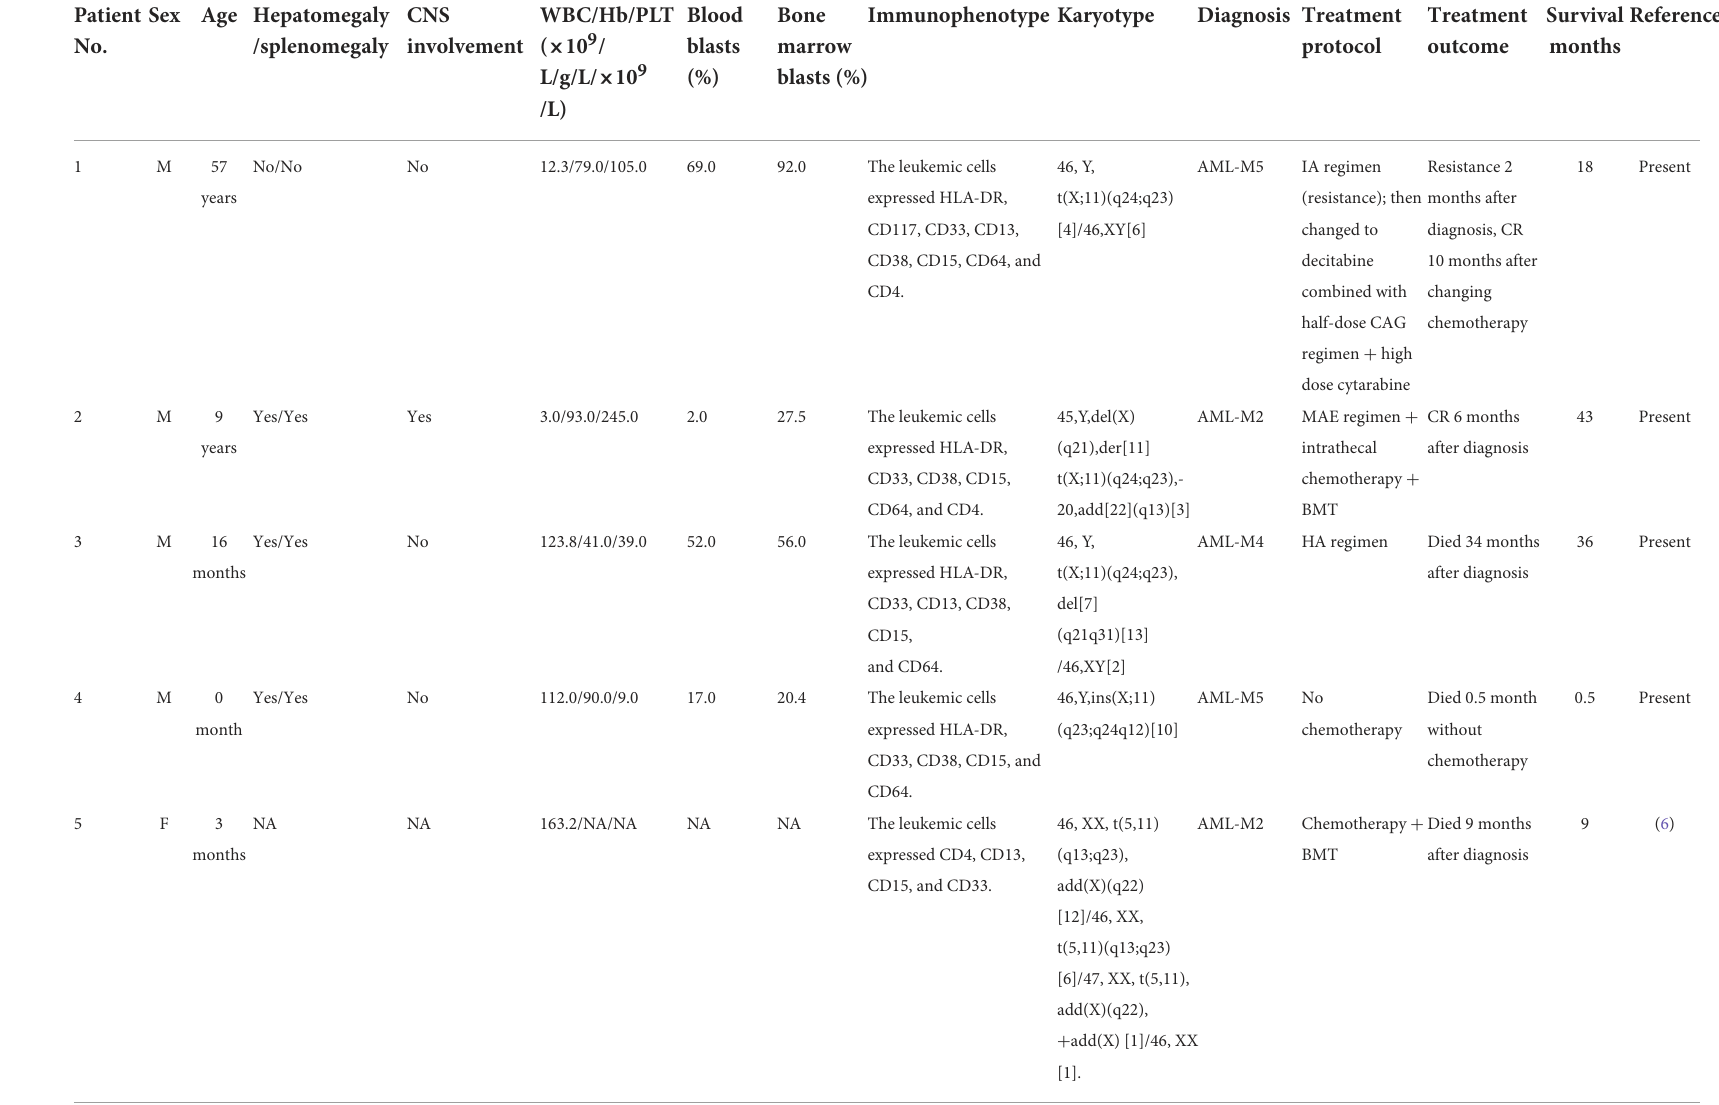
TABLE 2 Detailed characteristics of KMT2A-SEPT6 positive AML cases reported in the